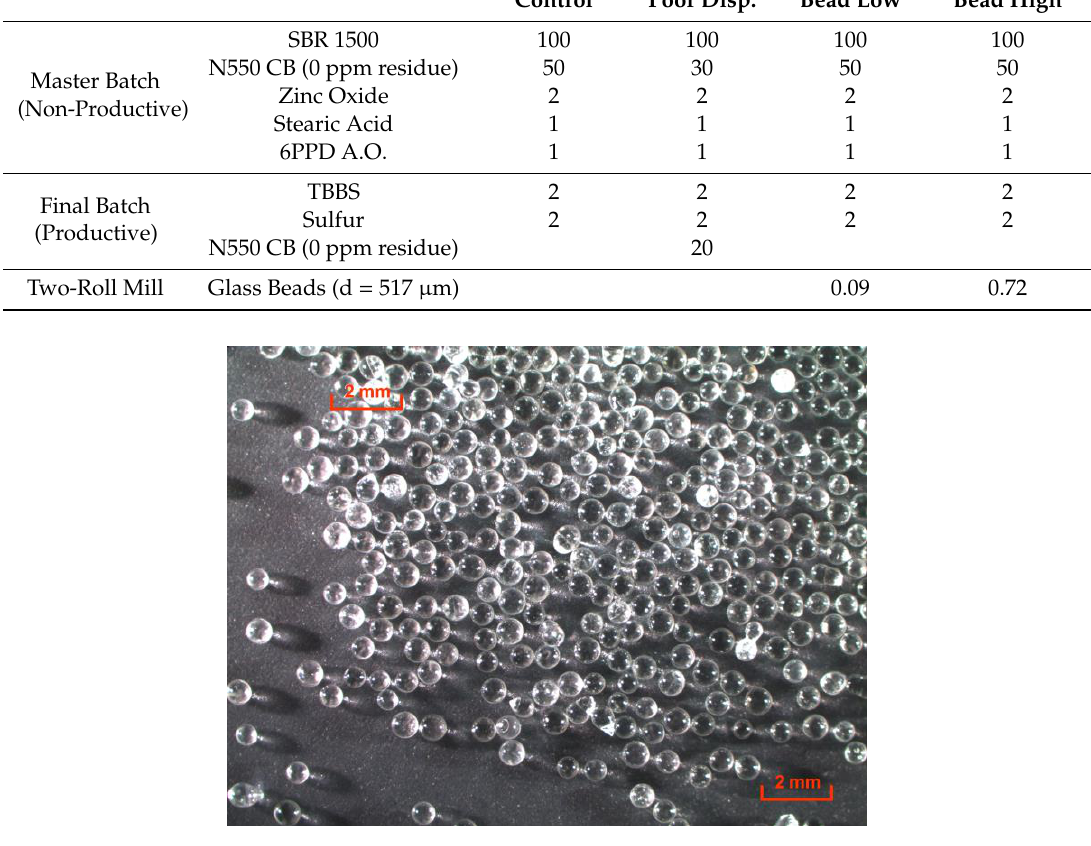
Table 1. Rubber Compound Formulations (phr).